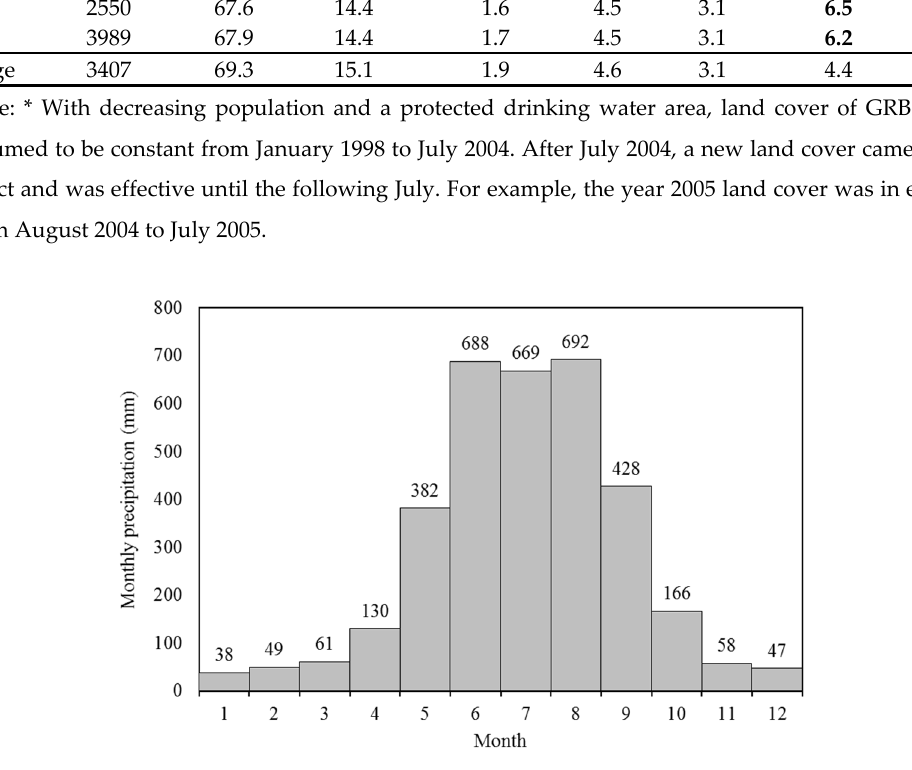
Figure 2. Monthly averaged precipitation of GRB during the study period